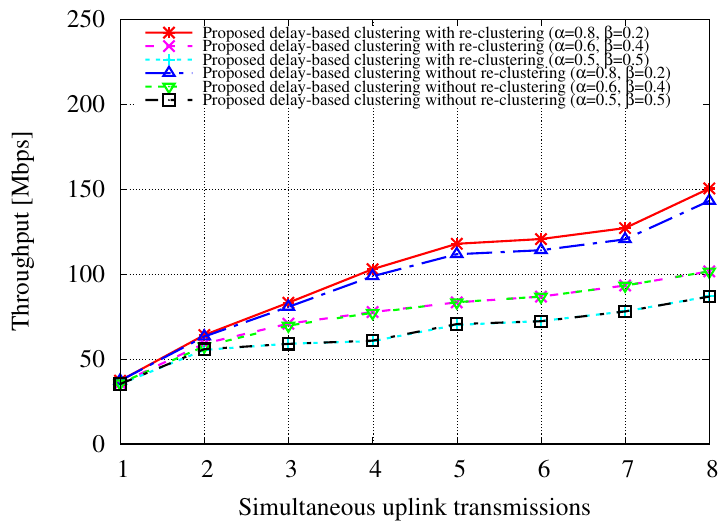
Figure 12. Network throughput performance (MCS of 40% stations changes, λ =